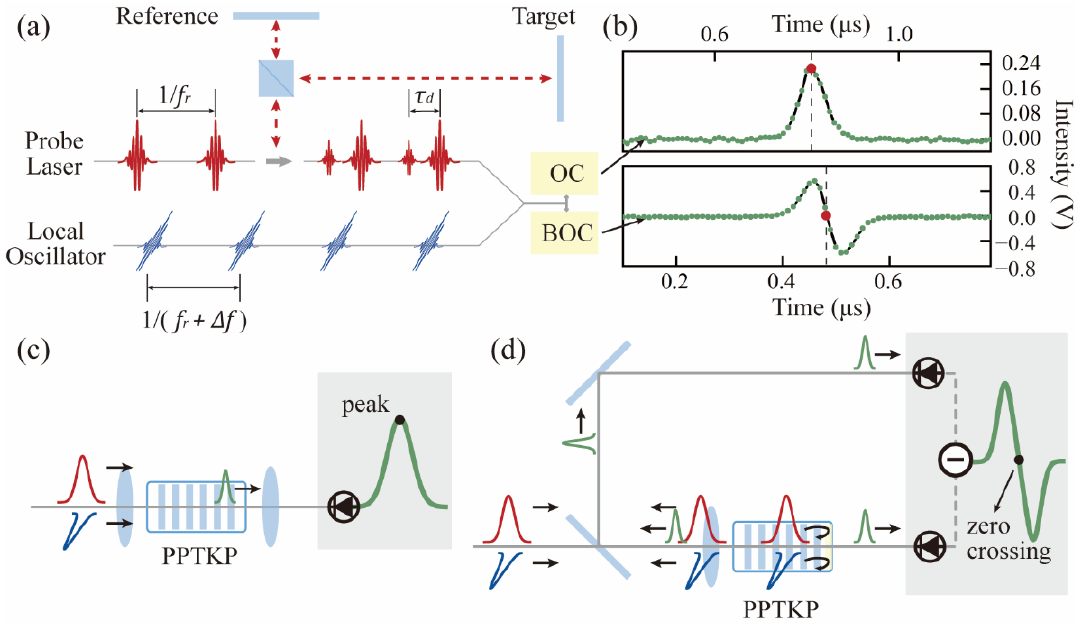
Figure 8. ( a ) Schematic setup of dual-comb absolute distance measurement using nonlinear ASOPS. ( b ) Ranging signal obtained in real-time. ( c ) Optical cross-correlator-based nonlinear ASOPS. ( d ) Balanced cross-correlator-based nonlinear ASOPS.